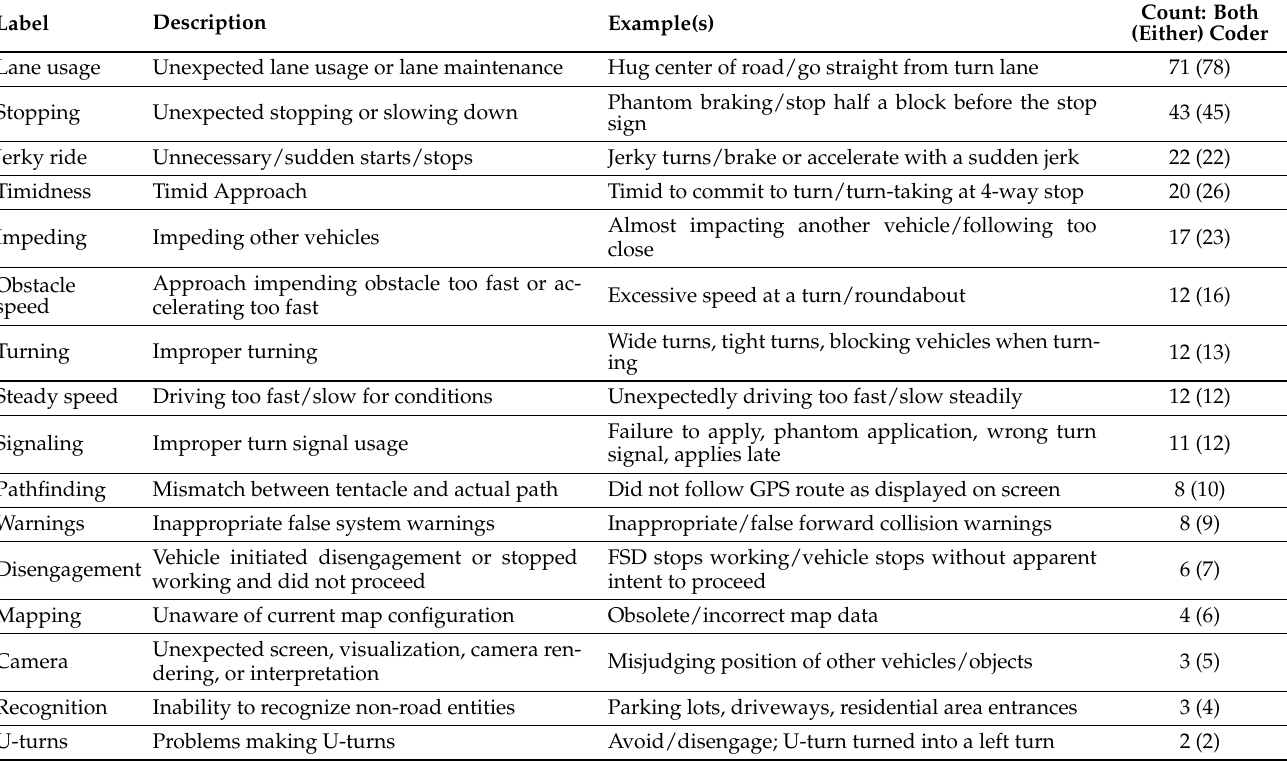
Table 1. List of coded categories of problems reported by social media users about Tesla